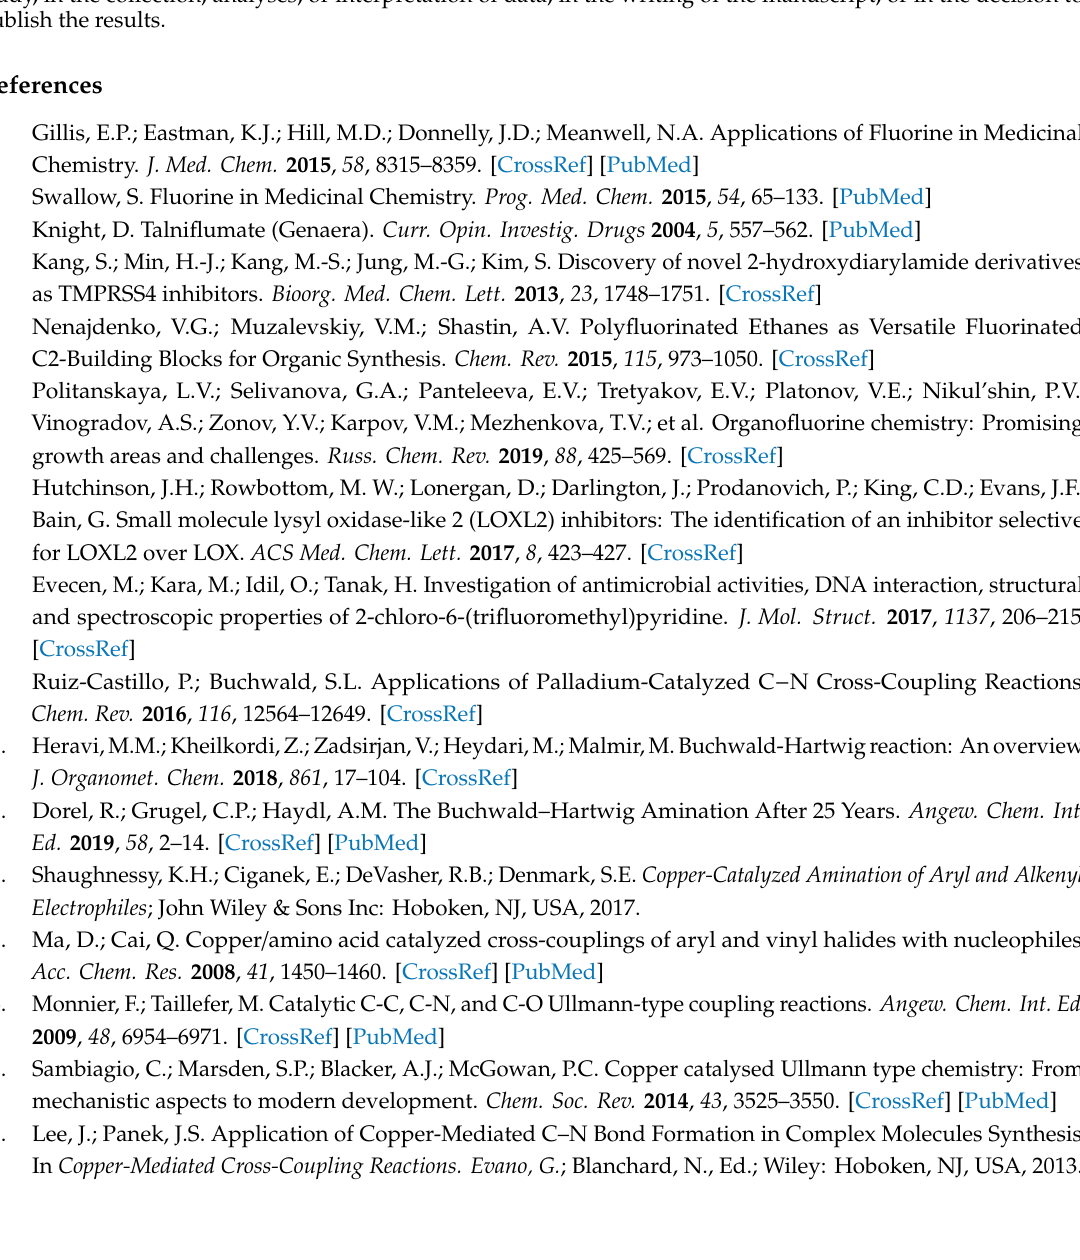
Table S1: Cu(I)-catalyzed arylation of oxadiamines 1–3 with fluoroiodo- and bromoflurobenzenes, Table S2: Pd(0)-catalyzed arylation of oxadiamines 1–3 with bromoflurobenzenes, Table S3: Cu(I)-catalyzed arylation of oxadiamines 1–3 with iodo(trifluoromethyl)benzenes, Table S4: Pd(0)-catalyzed arylation of trioxadiamine 1 with bromofluro(trifluoromethyl)benzenes, Table S5: Cu(I)-catalyzed arylation of trioxadiamine 1 with various aryl iodides (CuI / L1, 20 / 40 mol%), Table S6: Pd(0)-catalyzed arylation of trioxadiamine 1 with various aryl iodides, Schemes